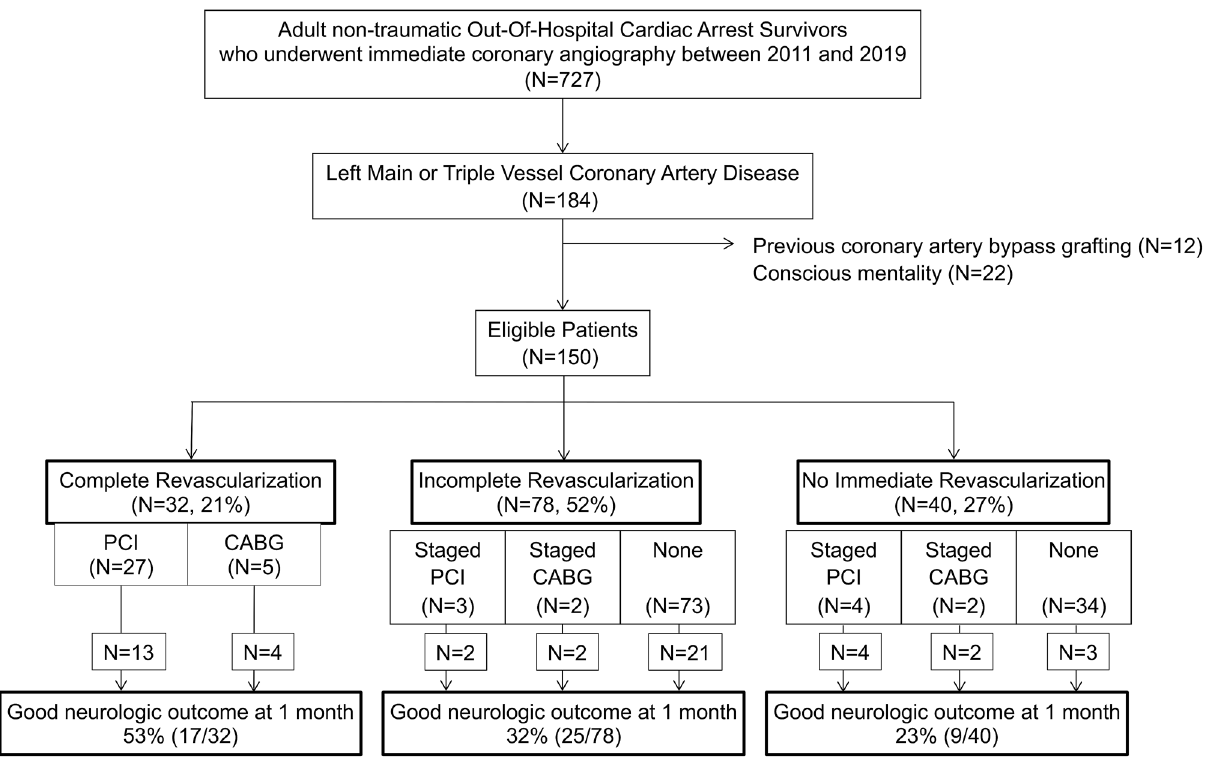
Figure 1. Flow diagram of the patient selection process. CABG coronary artery bypass grafting, PCI percutaneous coronary